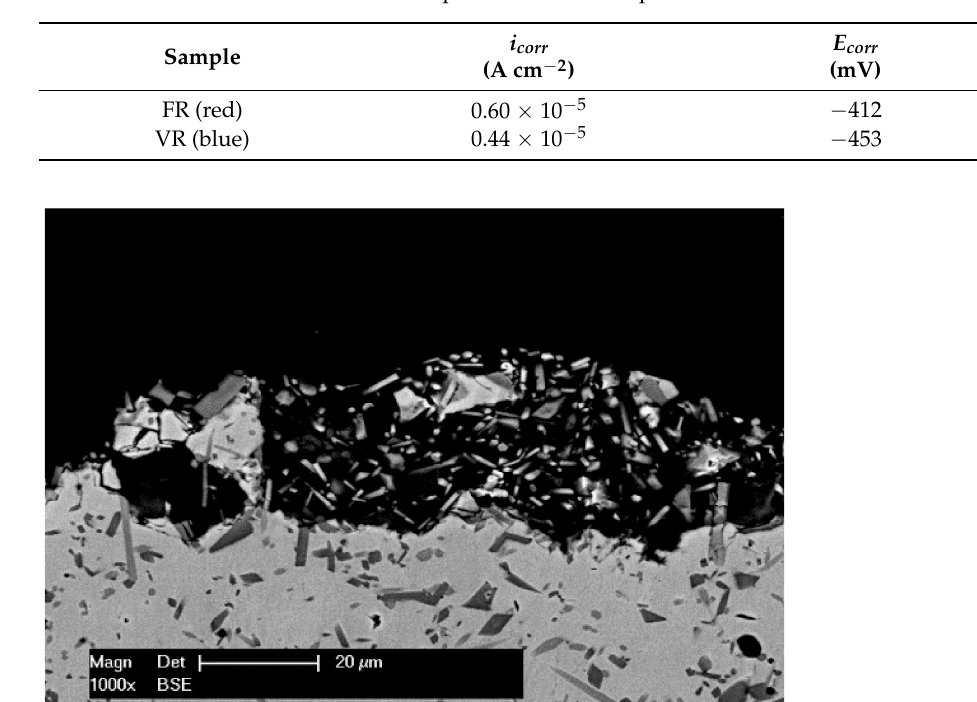
Figure 12. Polarization behavior of the remelted samples. Table 6. Corrosion current densities and potential of the samples.